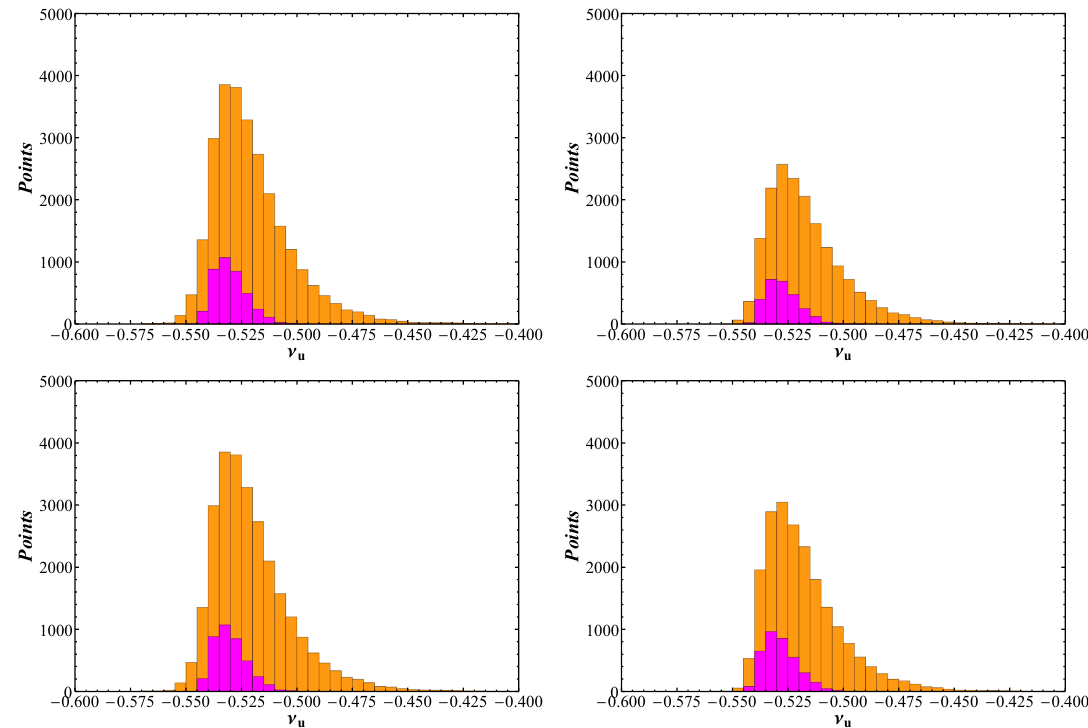
Figure 16. Histograms of the (cid:23) u for g A = g B = 0 : 1 and v F =k = 0 : 1 (top left), g A = g B = 1 : 0 and v F =k = 0 : 1 (top right), g A = g B = 0 : 1 and v F =k = 1 : 0 (bottom left), and g A = g B = 1 : 0 and v F =k = 1 : 0 (bottom right). The orange represents points which satisfy the 99.7% CL experimental limit in the h d (cid:0) (cid:27) d plane, and the magenta represents the subset of these points which also satisfy the constraint x 12 < 0 :